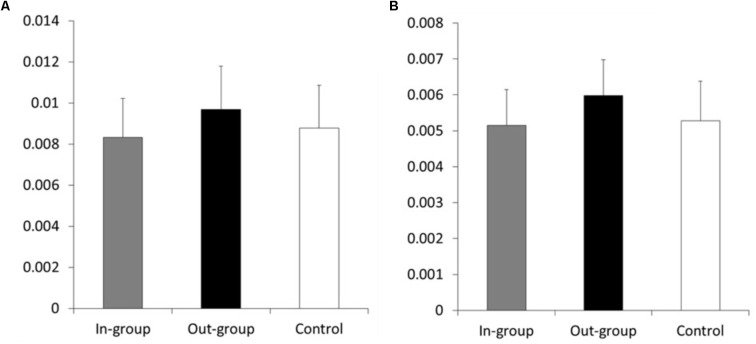
Participants’ discount rates (k) in each condition: (A) when the delayed money was 10,000 yen, and (B) when the delayed money was 20,000 yen. The error bars indicate SE.